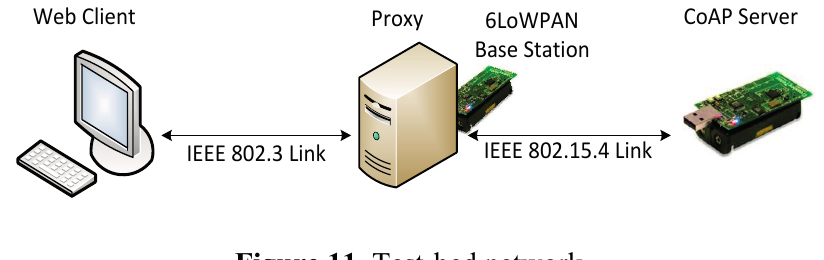
Figure 11. Test-bed